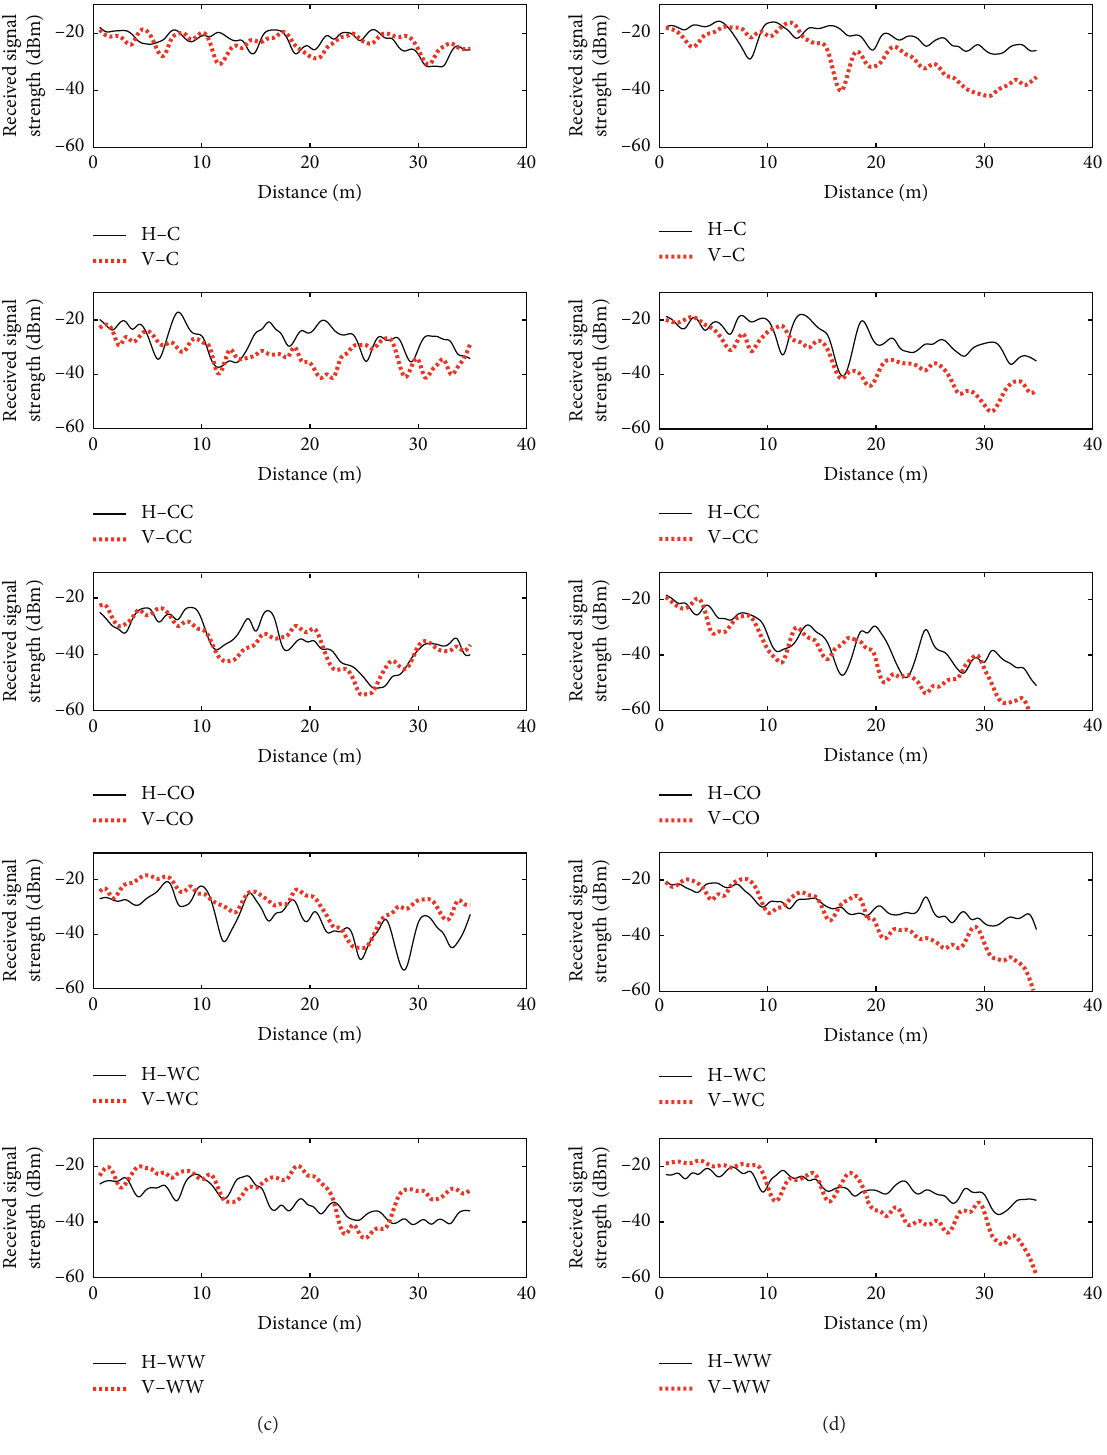
Figure 3: Distance-dependent signal power measured in the coal mine tunnel. V indicates vertical polarization, and H indicates horizontal polarization. (a) 900MHz signal in wide tunnel; (b) 433MHz signal in wide tunnel; (c) 900MHz signal in narrow tunnel; (d) 433MHz signal in narrow